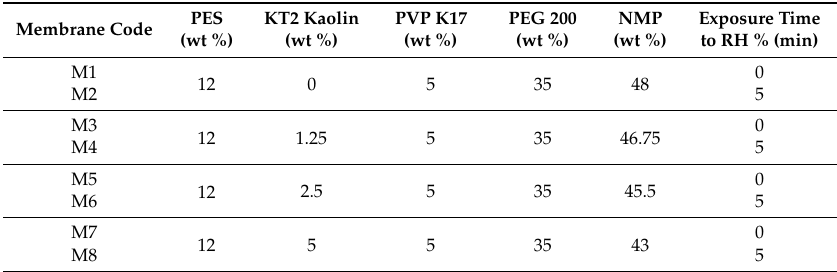
Table 2. Compositions of the casting solutions and exposure time to controlled temperature (25 ◦ C) and RH